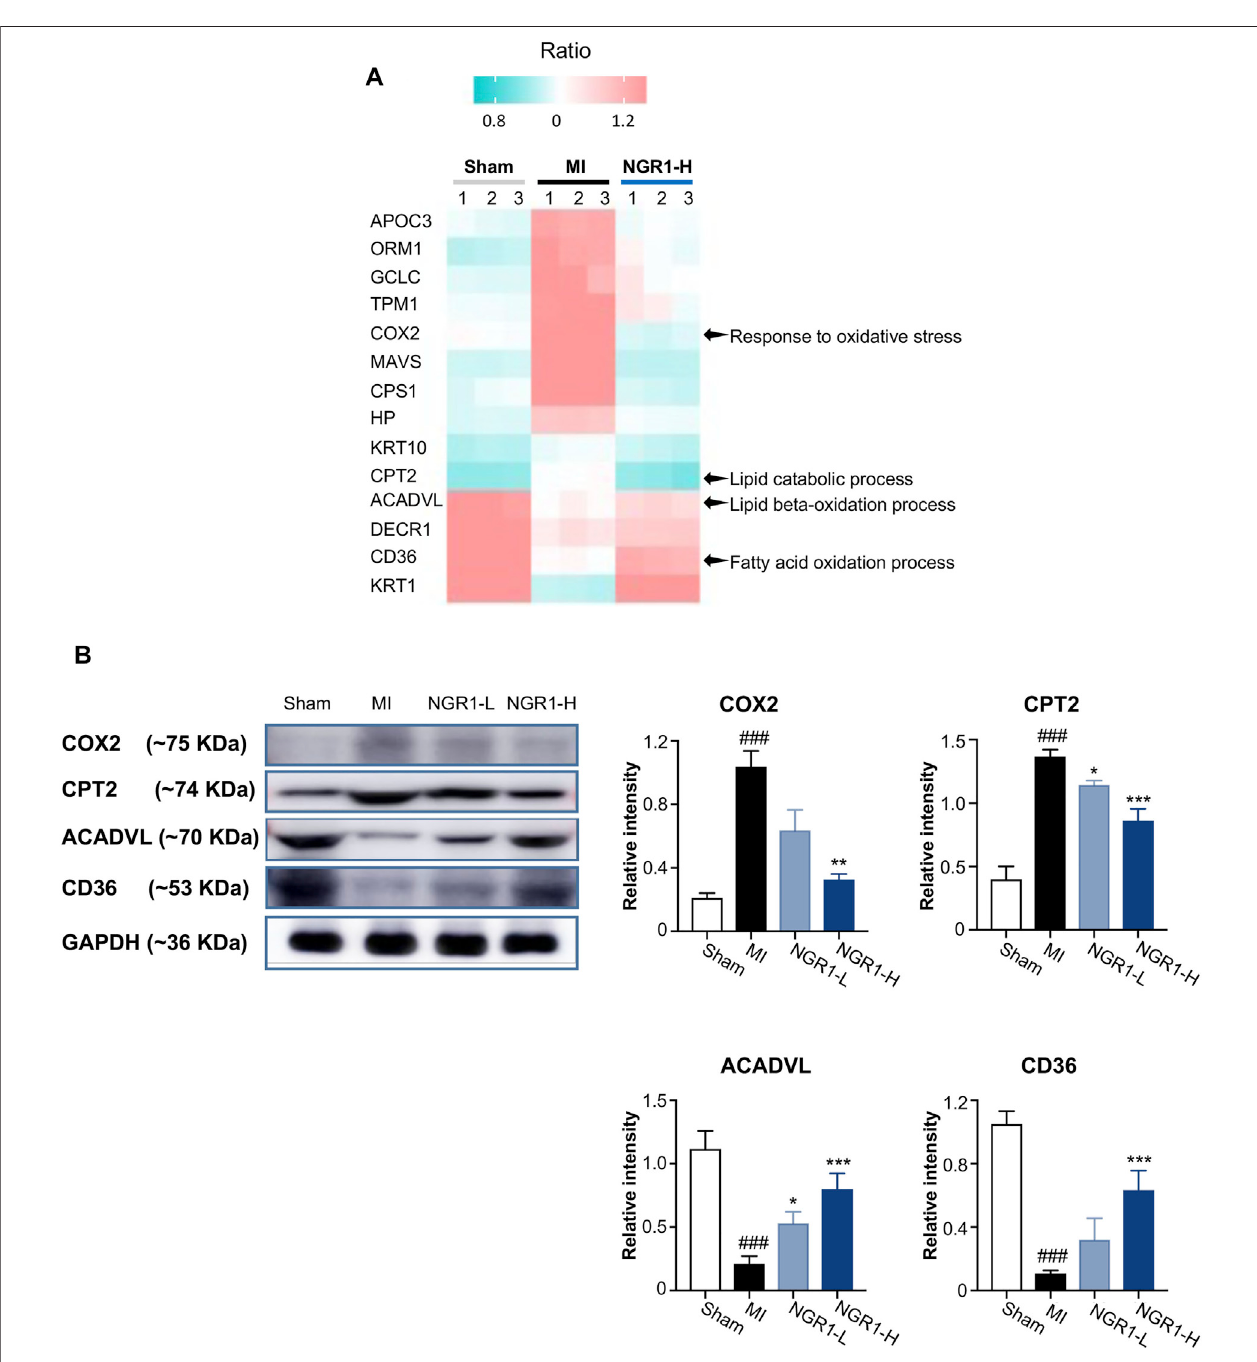
FIGURE 6 | Validation of key differential protein expression in the lipid metabolism – associated network. (A) Heatmap of differential proteins in the lipid metabolism – associatednetwork. (B) ExpressionofCOX2,CPT2,ACADVL,andCD36byWesternblots.Valuesexpressedasthemean±SD.* p < 0.05,** p < 0.01,and *** p < 0.001 vs. the MI group; # p < 0.05, ## p < 0.01, and #### p < 0.001 vs. the sham group ( n = 3 for sham, MI, NGR1-L, and NGR1-H groups).